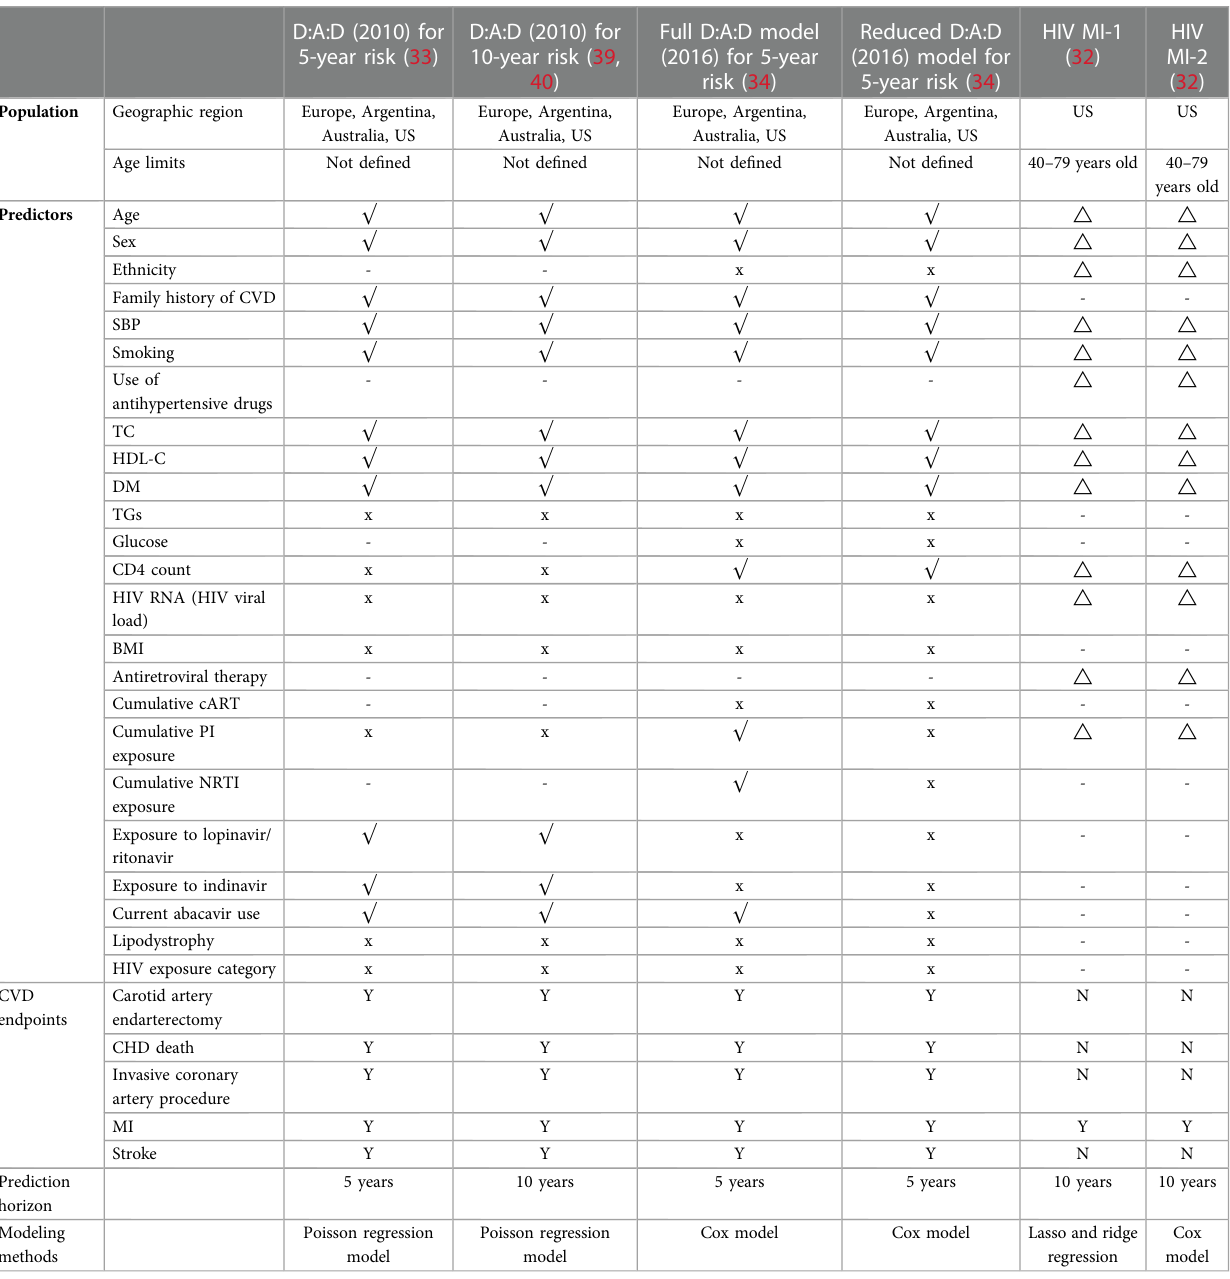
TABLE 2 Predictors and outcomes of six HIV-speci fi c